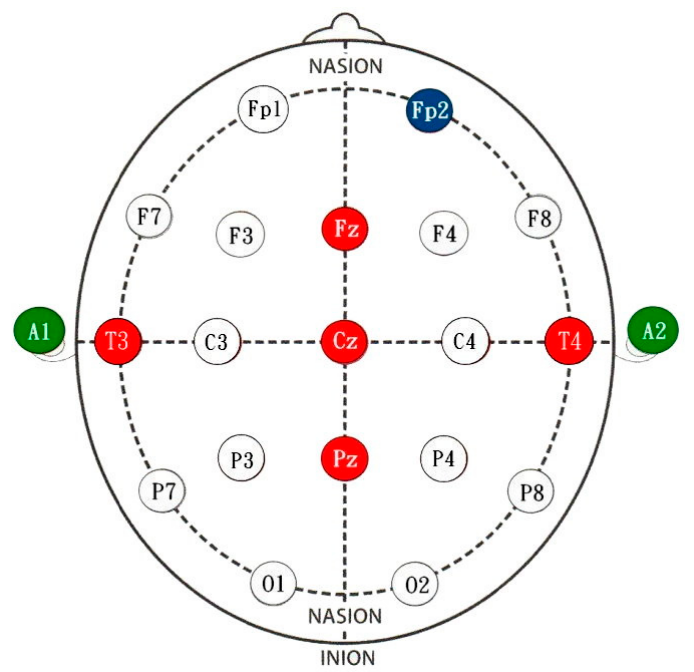
Figure 5. The positions of the electrodes based on the International 10–20 Location System. The green circles, A1 and A2, represent the reference electrodes. The ground electrode is the blue circle, FP2.